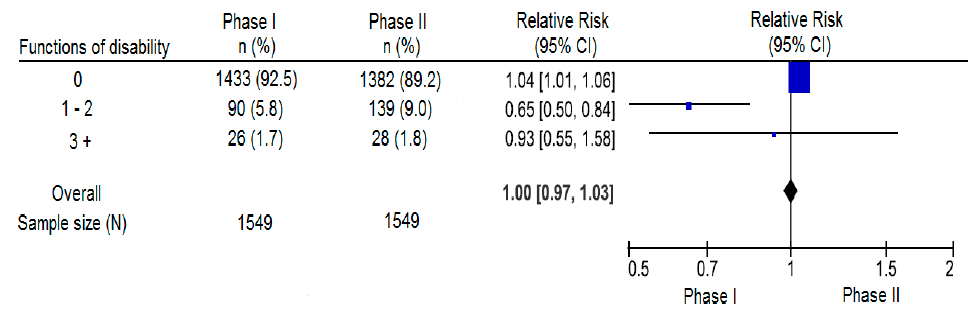
Figure 1. Forest plot showing the RR for three categories of number of disabilities between phase I and phase II.